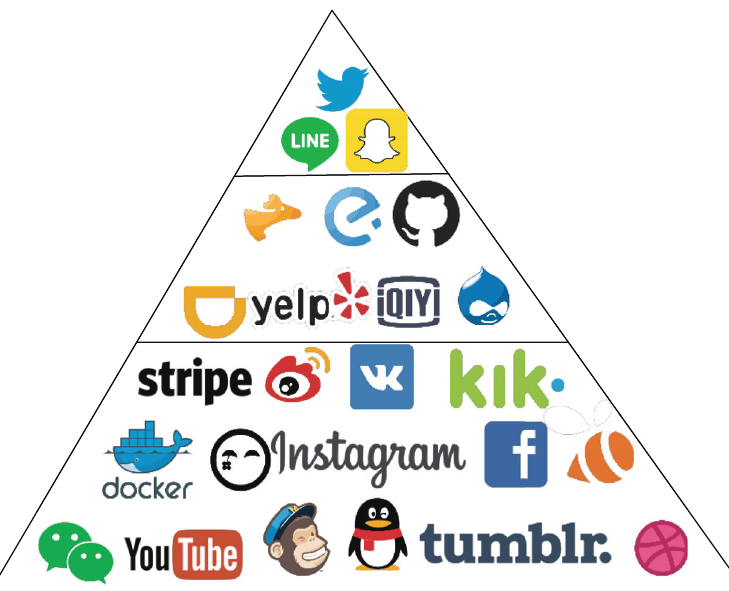
Figure 5: Some of the world ’ s most valuable